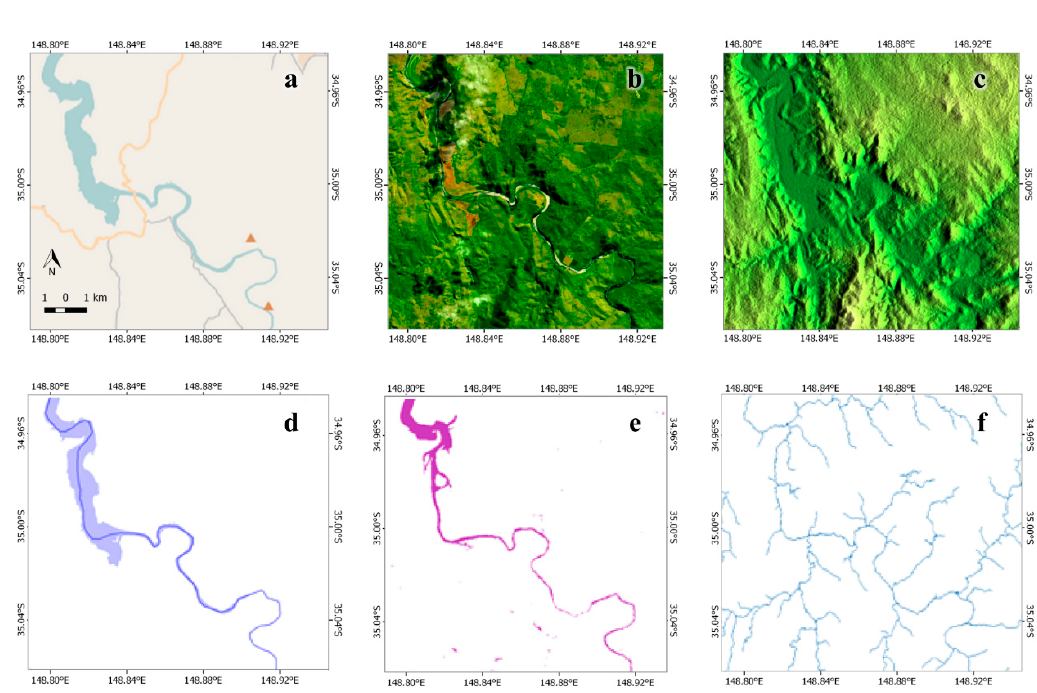
Figure 2. The datasets: OpenStreetMap ( a ); Landsat 8 ( b ) and 30m SRTM ( c ); and their corresponding water masks ( d – f ). Murrumbidgee River, north of Canberra.